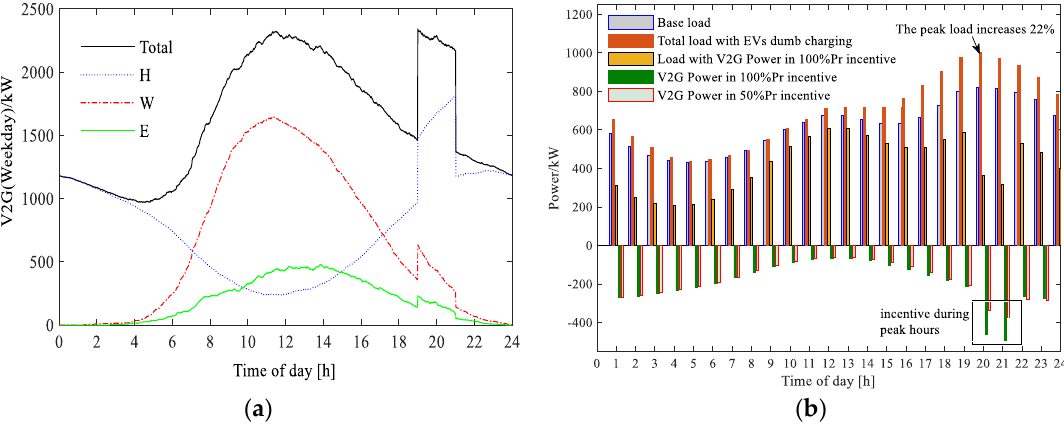
Figure 12. EVA-DR under different incentives. ( a ) V2G power expectation under high incentive compensation of peak hours (with 33% penetration); ( b ) EV charge randomly and different peak price incentives (H4: 240 EVs).